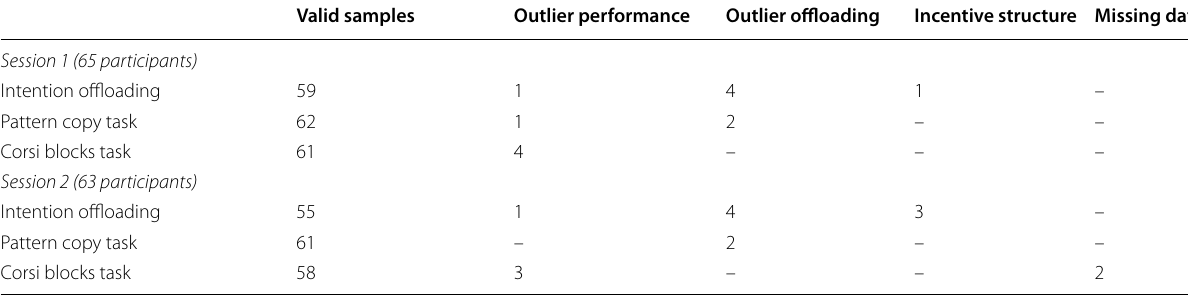
Table 1 Valid data sets and data exclusions separately for each task and session